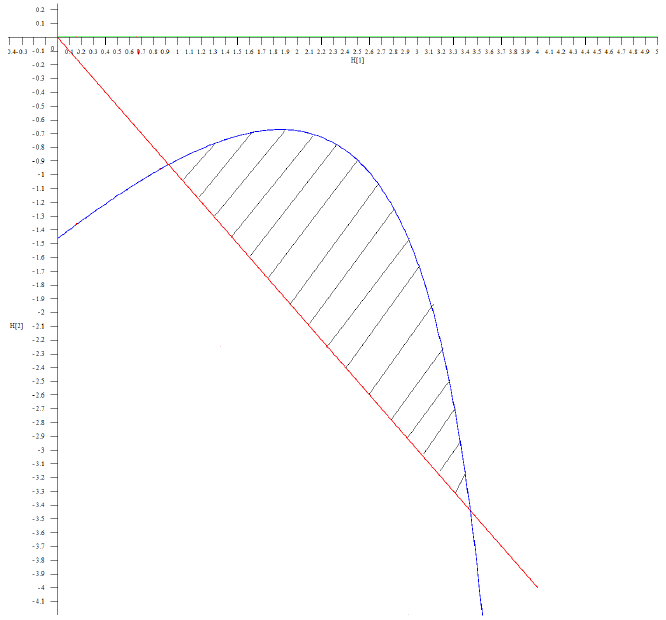
Figure 2. Stability region for